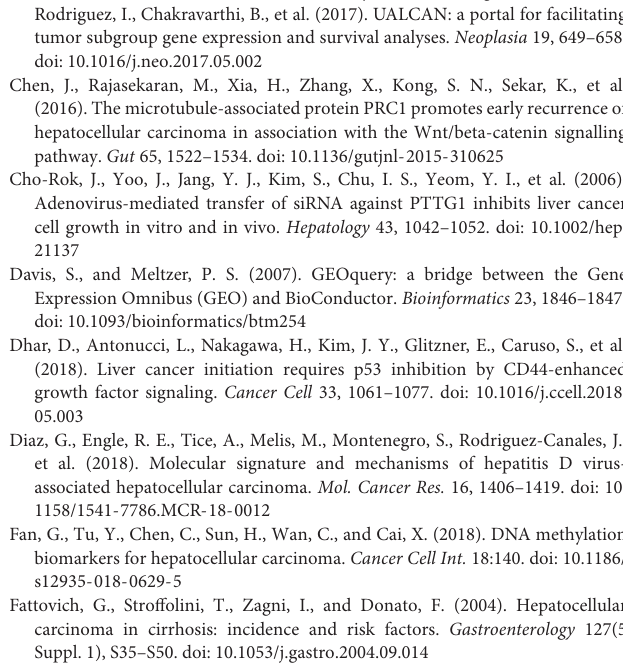
FIGURE S1 | Liver carcinogenesis-related module identified from GSE89377, GSE17548, and GSE56140. FIGURE S2 | Liver carcinogenesis-related module identified from GSE98383, GSE17548, and GSE56140. FIGURE S3 | Liver carcinogenesis-related module identified from GSE98383, GSE89377, and GSE56140. FIGURE S4 | Verification of the identified modules for discriminating cirrhosis from HCC in GSE98383. FIGURE S5 | Verification of the identified modules for discriminating cirrhosis from HCC in GSE89377. FIGURE S6 | Verification of the identified modules for discriminating cirrhosis from HCC in GSE17548. TABLE S1 | Fold changes of the differentially expressed genes shared in GSE98383, GSE89377, and GSE17548. TABLE S2 | Significantly enriched KEGG pathways of the shared DEGs. TABLE S3 | Significantly enriched KEGG pathways of the genes in the identified gene module. TABLE S4 | Information of the genes in the identified